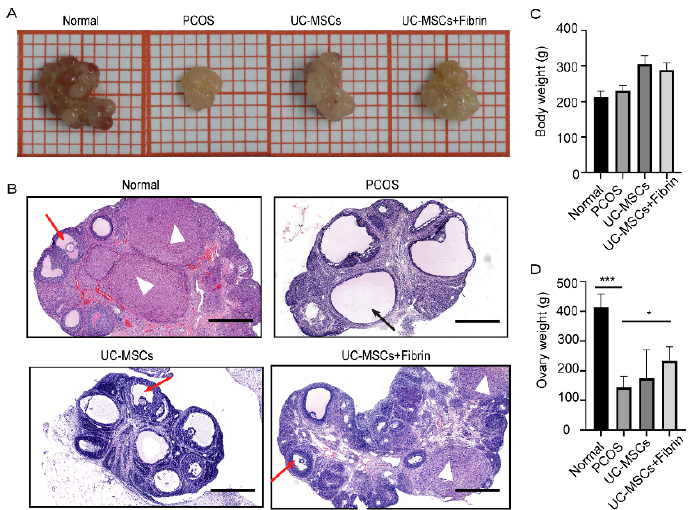
Figure 4. Comparison between ovary size and follicular morphology after implantation. ( A ) A representative ovary from various groups showing relative ovary size. ( B ) Ovarian and follicular morphology in various groups were examined by haematoxylin and eosin (H&E) staining. Ovaries with thicker granular layer and a higher number of cells in the corpus luteum were assessed in the normal and UC-MSCs + fibrin group. Black arrow: cystic follicle with fewer granules, red arrow: follicle with more granules, white triangle: corpus luteum (scale bar, 500 μm). ( C ) Mean body weight did not significantly differ among all groups. ( D ) Ovary weight significantly differed between the PCOS and normal groups (*** p < 0.001) and between PCOS and UC-MSCs + fibrin groups (* p < 0.5).